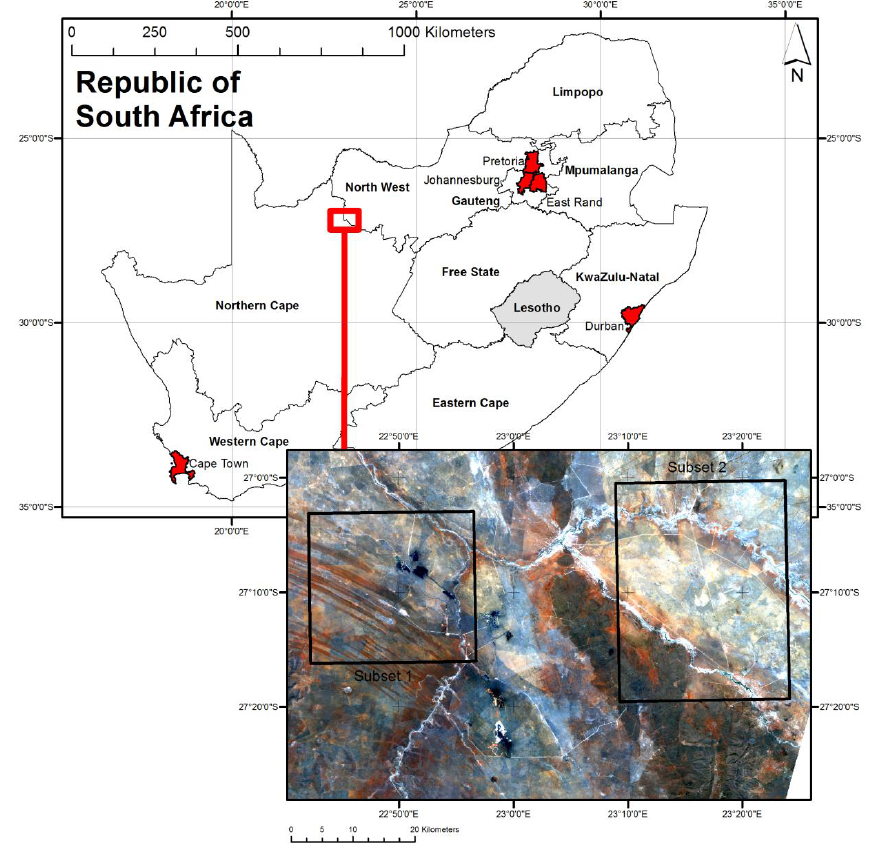
Figure 1. Location of study area. Subsets are indicated by black frames. The RapidEye image (true-colour RGB image using bands 3, 2 and 1) was acquired on 16 November 2011. Distinctive landmarks visible in the western part are sand dunes stretching from northwest to southeast and the Gamogara riverbed stretching from south to north. The eastern part shows the riverbed of Kuruman river stretching from west to east, and foothills of the Kuruman mountains stretching from southeast to